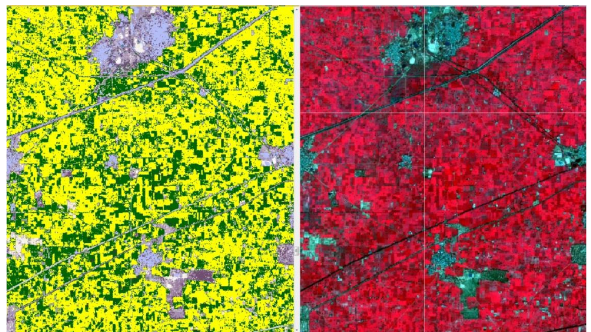
Figure 9. Classified image of Rapeseed & Mustard and FCC (False Colour Composite) of Mahendragarh District,